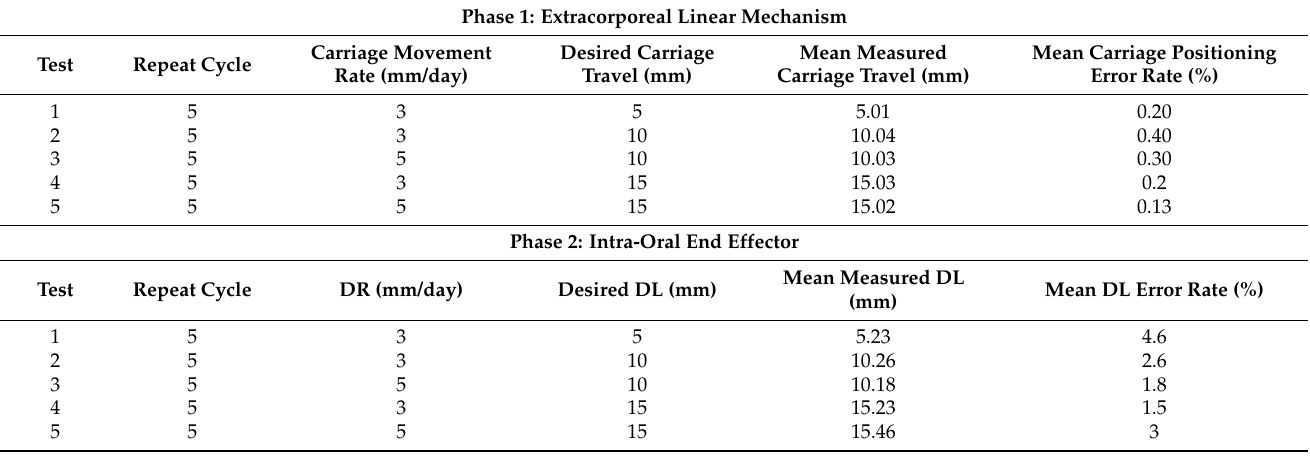
Table 1. Measurement of the linear positioning and the generated force.